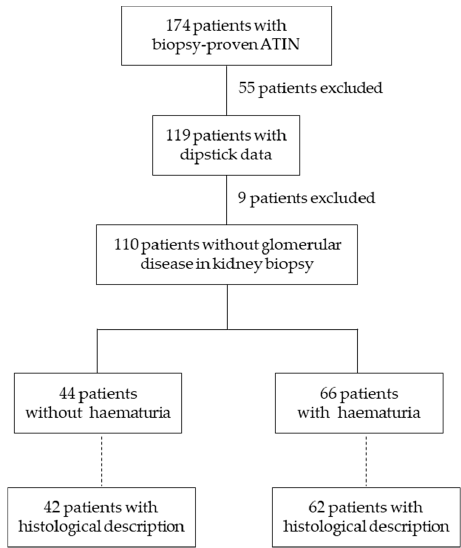
Figure 1. Patient disposal. ATIN, acute tubulointerstitial nephritis.